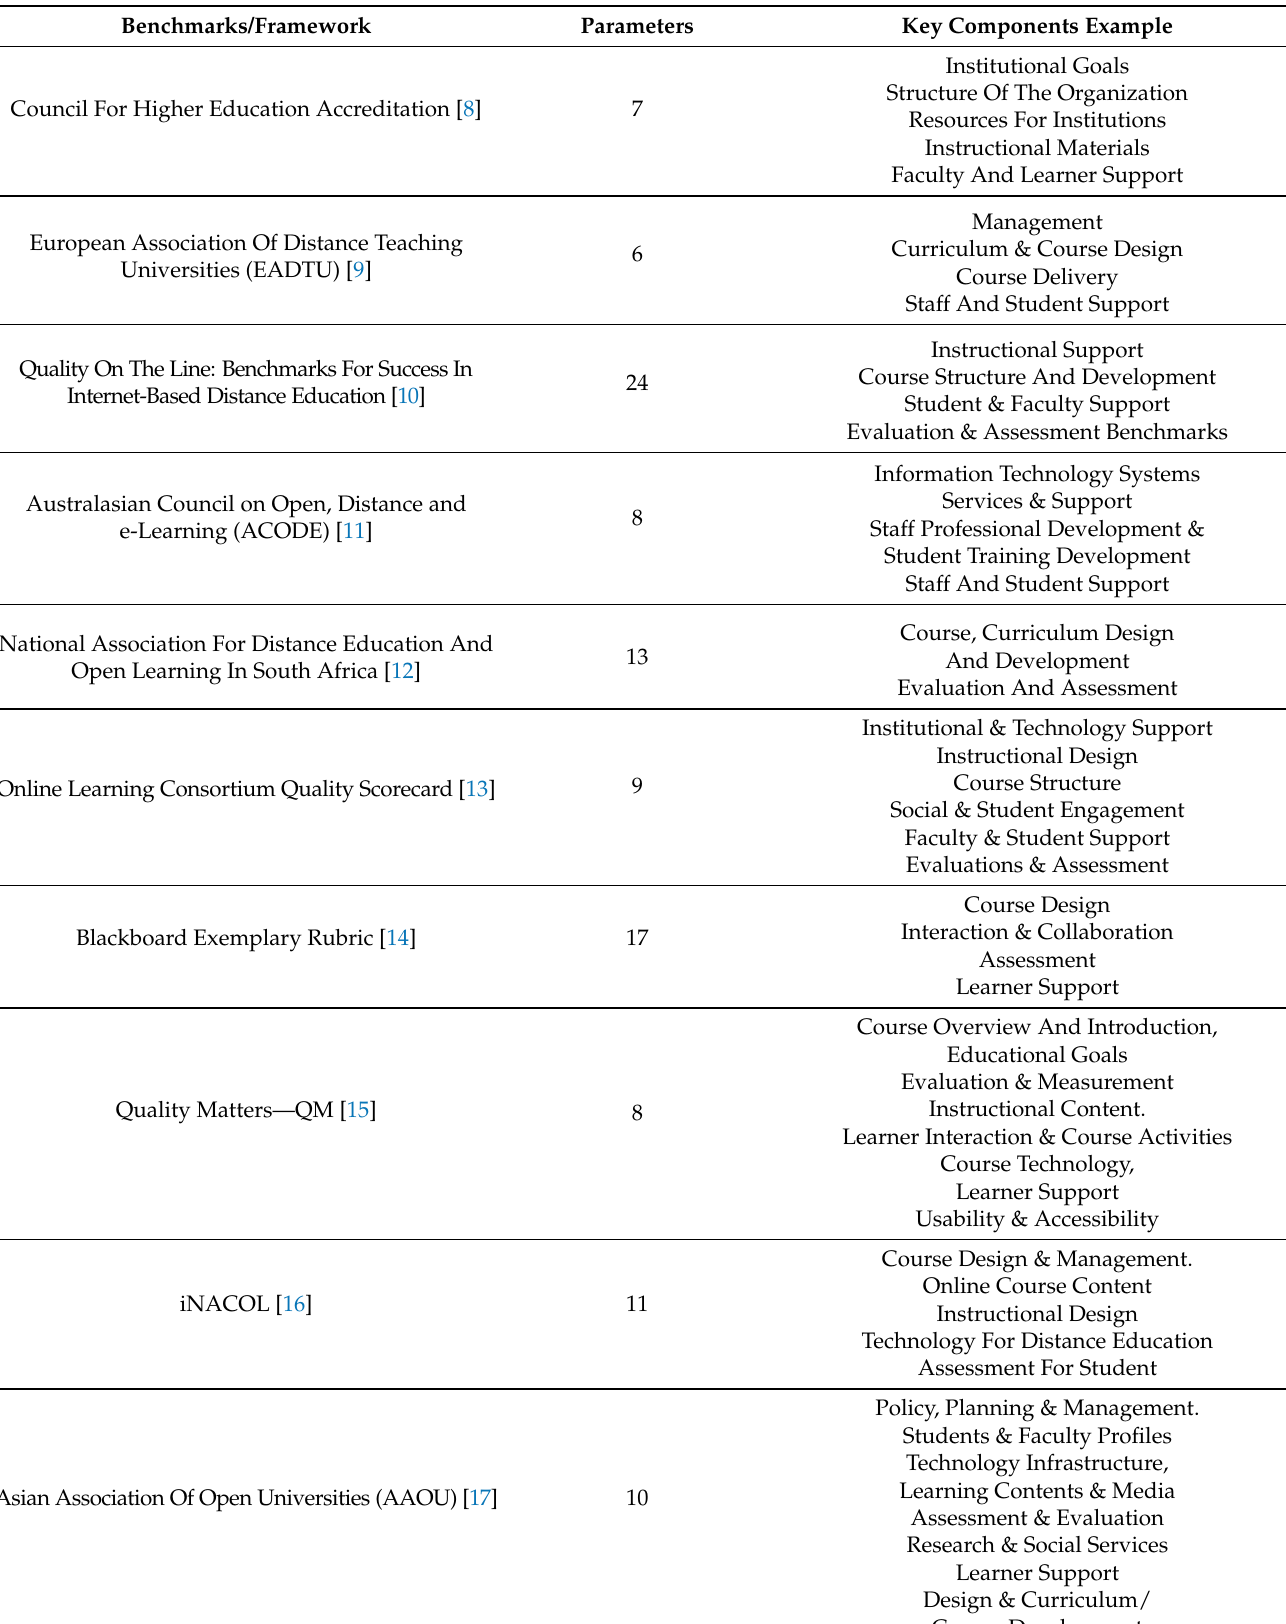
Table 1. Quality benchmarks—frameworks for